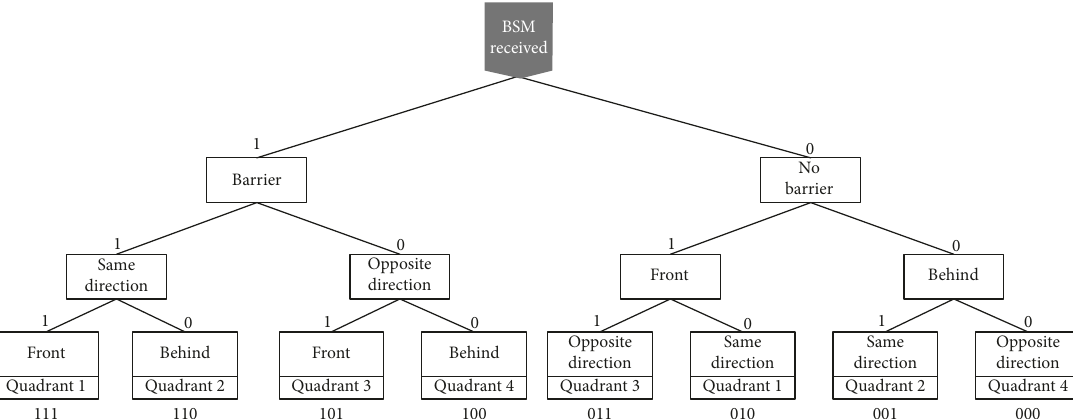
Figure 3: BSM rank based on road configuration (with/without a barrier), location, and direction of transmitting